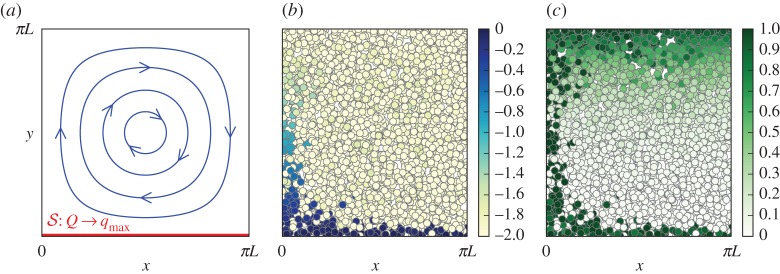
Steady-state problem. (a) Schematics showing the streamlines (4.1) and the moisture source at the bottom boundary. (b and c) Snapshots from a Monte Carlo simulation of (2.2) with ϵ=10−2 showing the positions of the moist parcels; the colour scales indicate the value of log10⁡Q (b) and the relative humidity Q/qs(Y) (c). (Online version in colour.)